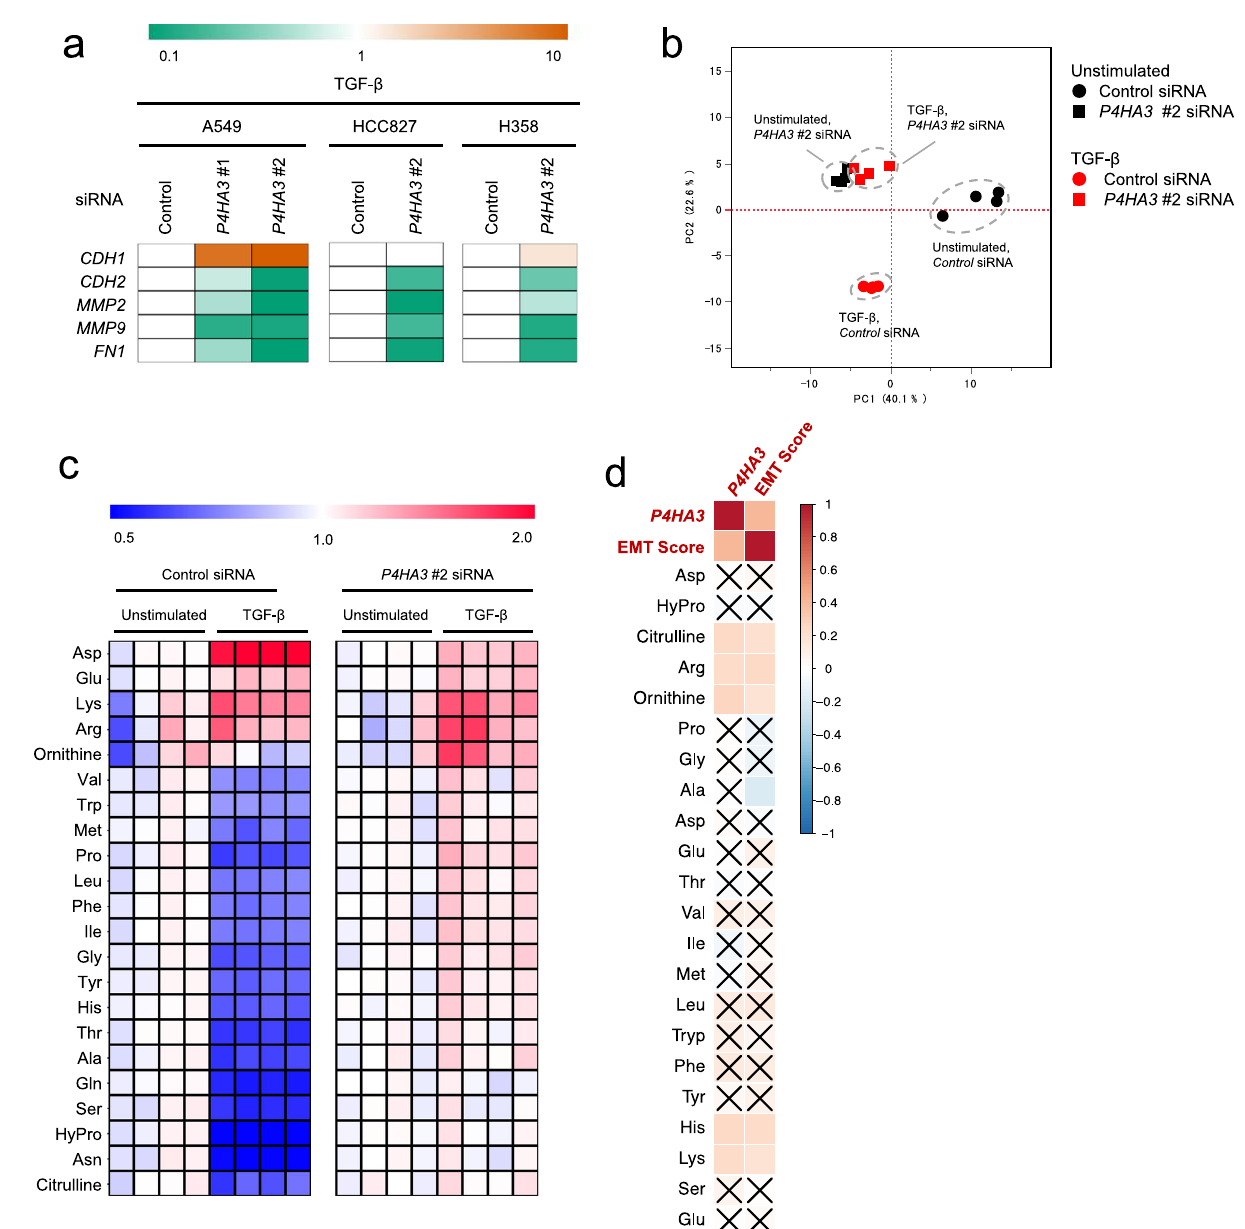
Fig. 5 Effect of P4HA3 knockdown on epithelial – mesenchymal transition (EMT) marker expression and altered amino acid metabolism in TGF- β -stimulated lung cancer cells. a Effect of P4HA3 siRNA on EMT marker expression in TGF- β -treated A549, HCC827, and H358 cells. Cells transfected with P4HA3 siRNAs were treated with TGF- β for 48 h. mRNA expression levels of CDH1 , CDH2 , FN1 , MMP2 , and MMP9 were measured by real-time PCR. Orange and green indicate higher and lower levels, respectively, compared to mRNA levels in cells transfected with control siRNA (white). b Principal component analysis for metabolomics pro fi les of the P4HA3-knockdown A549 cells stimulated with or without TGF- β ( n = 4). Metabolite levels were detected by capillary electrophoresis time-of- fl ight mass spectrometry. The black and red plots indicate unstimulated and TGF- β -stimulated, respectively, cells. The circle and square indicate control and P4HA3 siRNA-treated cells, respectively. c Effect of P4HA3 siRNA on TGF- β -induced amino acids alteration in A549 cells. Heat map depicts the ratios of measured sample to mean of unstimulated sample concentrations. Red and blue indicate higher and lower levels, respectively, of metabolites in TGF- β -stimulated cells compared to those in the unstimulated cells (white). d Correlations between amino acid levels, EMT score, and P4HA3 mRNA expression in NSCLC cell lines in the CCLE dataset. Positive correlation is indicated in red and negative correlation in blue. × indicates no signi fi cance ( P >